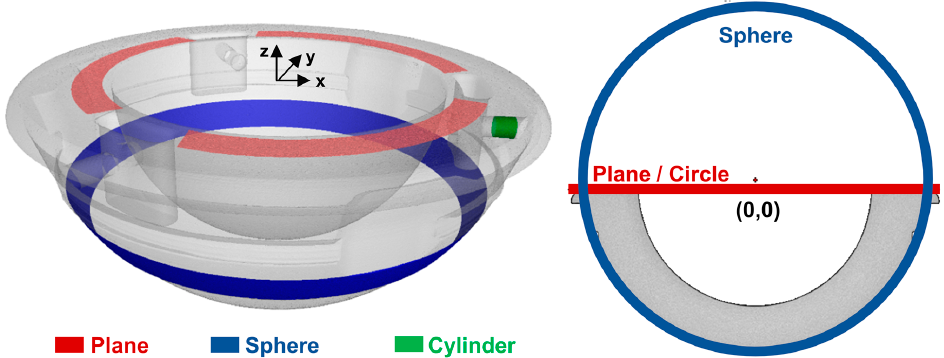
Figure 4. Unworn and nondeformed regions selected to create the geometrical elements used for the alignment ( left ) and 2D representation of the resulting fitting sphere, fitting plane, and intersection circle ( right ).